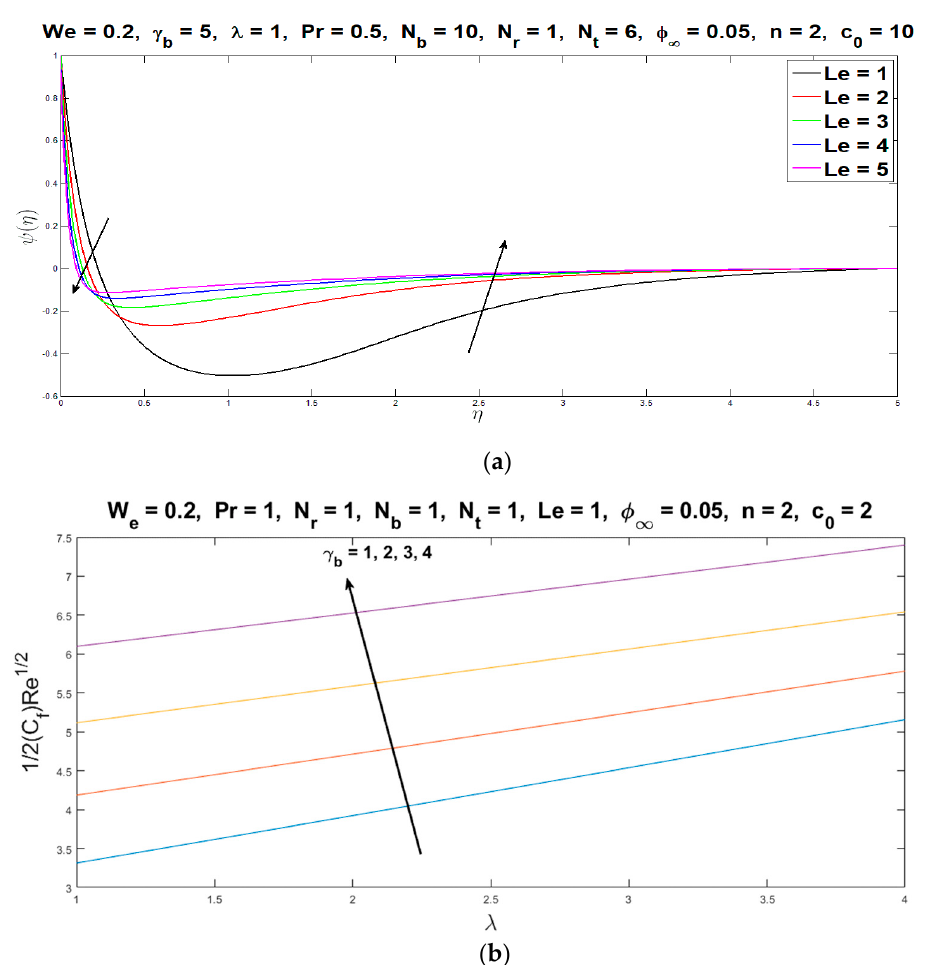
1 𝐶 (cid:3033) 𝑅 2 e against λ C f R (cid:3032) 2 (cid:2870)